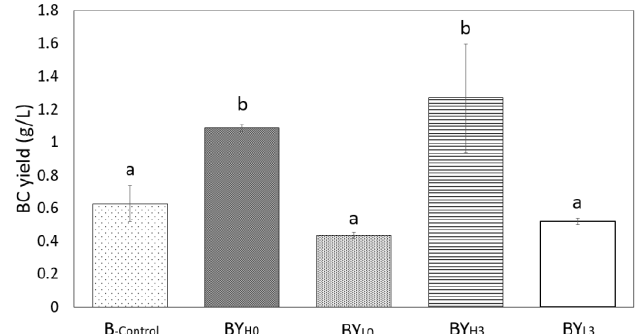
Figure 9. Effect of D. bruxellensis concentration and inoculation time on BC final yield by produced by K. intermedius . D. bruxellensis was added simultaneously at concentrations of 10 6 CFU/mL (BY H0 ) and 10 3 CFU/mL (BY L0 ) and sequentially at 10 6 CFU/mL (BY H3 ) and 10 3 CFU/mL (BY L3 ). Means with different letters are significantly different ( p < 0.05).